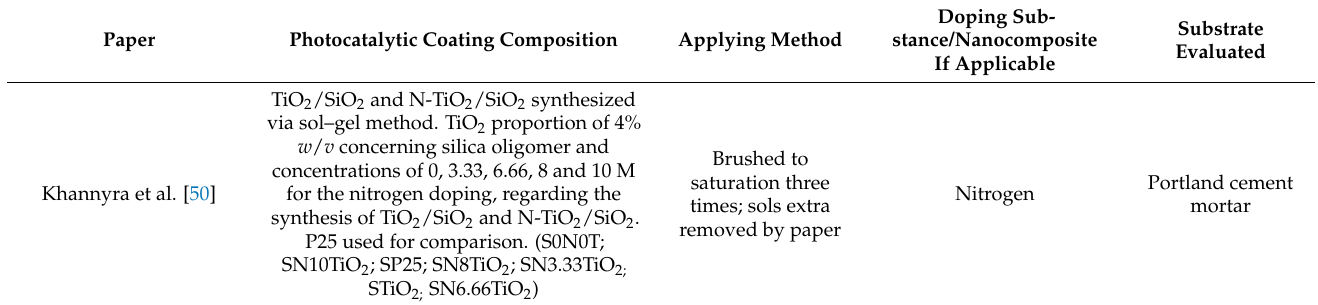
Table 2. Core papers presenting experimental results on self-cleaning ability, depolluting effect, antimicrobial effect, or durability. The entry “ - “ is for information unavailable or not applicable.